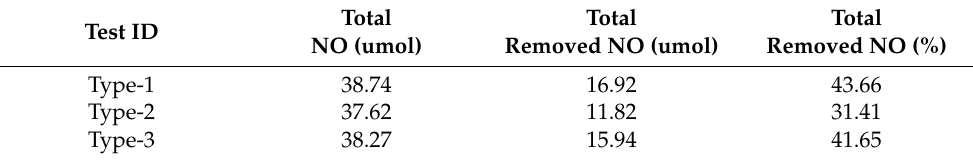
Figure 8. Variation of NOx concentrations during the mixed tank photo reactor experiment. Table 7. NO reduction and reduction efficiency of mixed tank photo